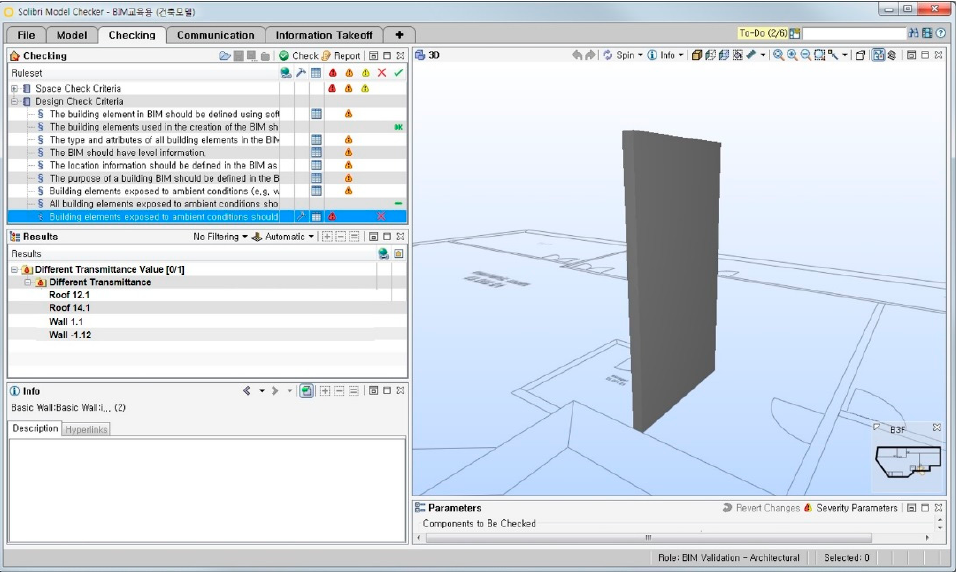
Figure 6. Example of rule-based quality checking results according to design check criteria (e.g., Figure6. Exampleofrule-basedqualitycheckingresultsaccordingtodesigncheckcriteria(e.g.,criterion, criterion, heat loss prevention; rule, thermal transmittance checking). heat loss prevention; rule, thermal transmittance